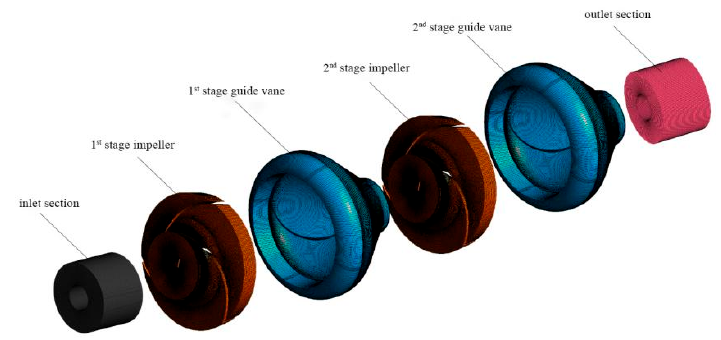
Figure 7. Model pump computational domain mesh.